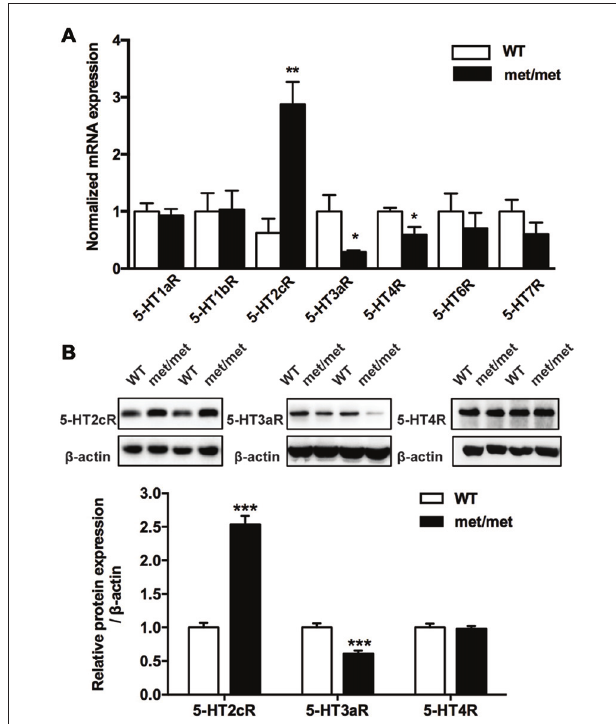
FIGURE 5 | Altered expression of 5-hydroxytryptamine (5-HT) receptors. (A) qRT-PCR of 5-HT receptor gene in the hippocampus. The mRNA expression of 5-HT2cR was up-regulated, yet the mRNA of 5-HT3aR and 5-HT4R was down-regulated in the hippocampus of BDNF Met / Met mice (WT: N = 11; BDNF Met / Met : N = 10). (B) Western blot analysis of the 5-HT receptor protein. 5-HT2cR protein increased, while 5-HT3aR protein decreased in BDNF Met / Met mice (WT: N = 11; BDNF Met / Met : N = 10). ∗ P < 0.05, ∗∗ P < 0.01, ∗∗∗ P <